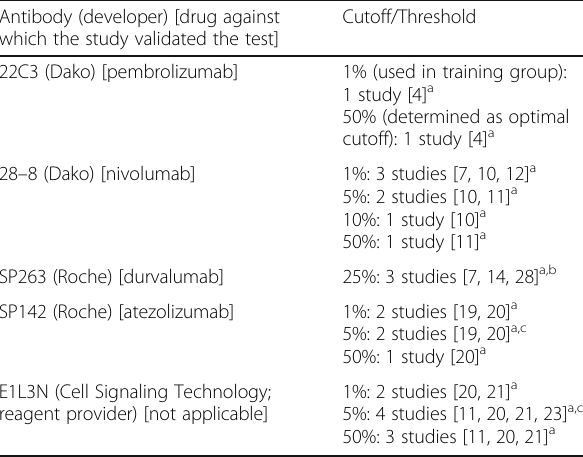
Table 2 Dichotomous Scoring Used Across Antibodies for PD- L1 IHC Tests in Lung Cancer Antibody (developer) [drug against which the study validated the test]